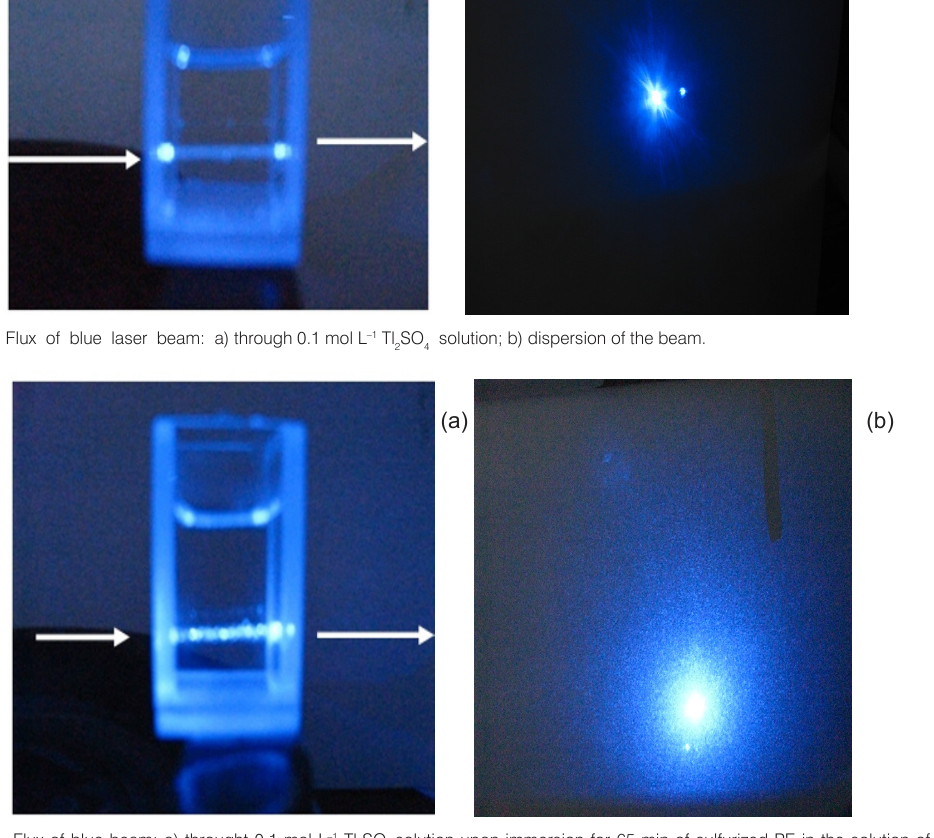
SO solution upon immersion for 65 min of sulfurized PE in the solution of H 2 4